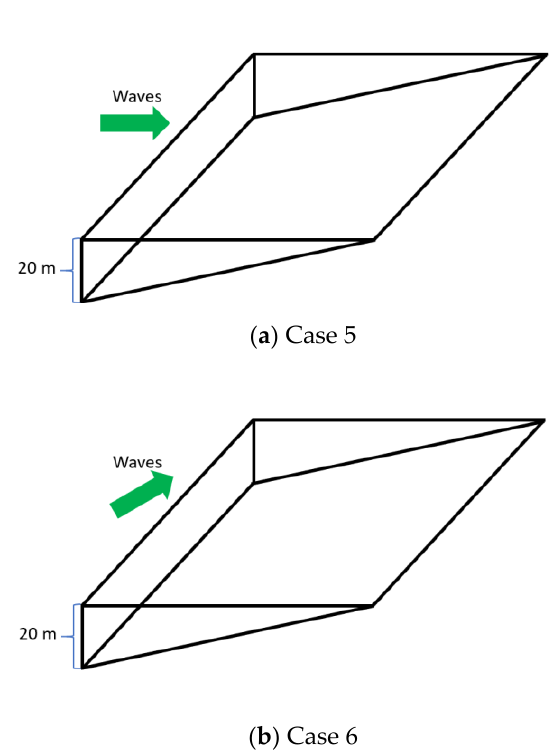
Figure 7. Schematic of test cases 5 and 6 for the wave propagation over an inclined flat bottom and in a quiescent current field.